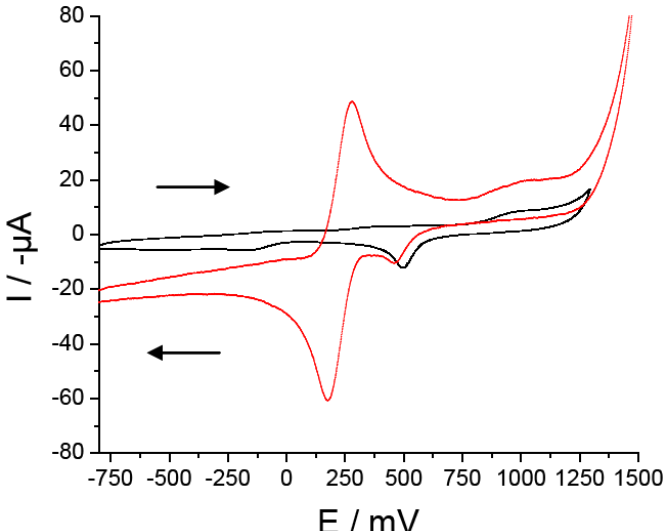
Figure 1. Au working electrode characterization by cyclic voltammetry in phosphate buffer with ferricyanide (red curve) and phosphate buffer (black curve). Scan rate: 25 mV·s − 1 . The scan direction is indicated by a black arrow. Ordinate shows negative current (I) values ( − μ